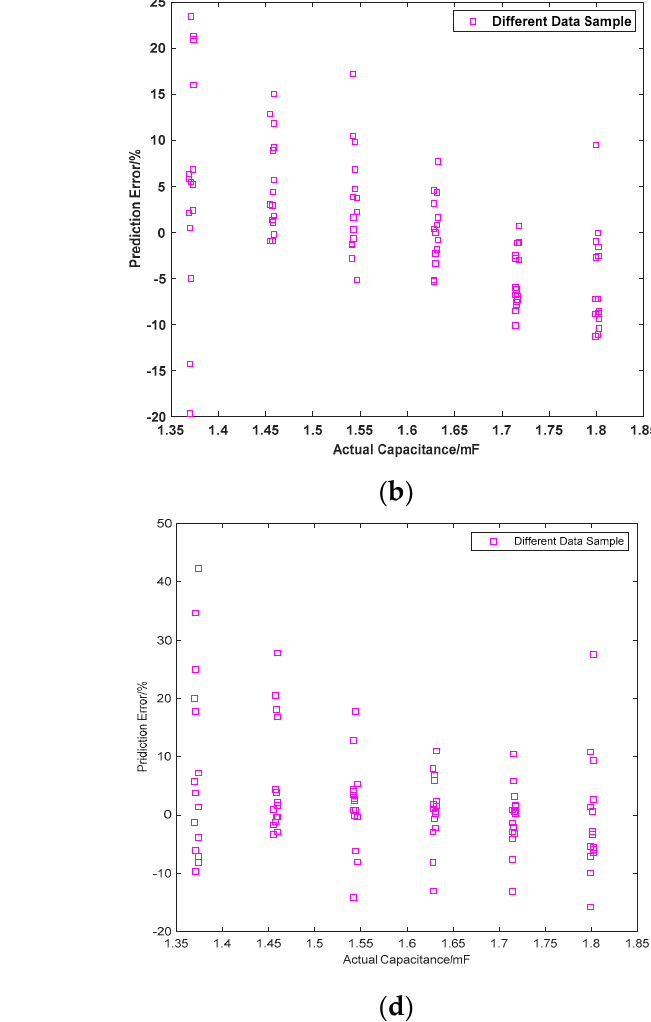
Figure 12. C estimation results under experiments by ANN ( a ) a best fitting showing train, test and validation results when Nc = 10; ( b ) cross validation showing PEs for 10 fittings under 10 random data divisions when Nc = 10; ( c ) a best fitting showing train, test and validation results when Nc = 100; ( d ) cross validation showing PEs for 10 fittings under 10 random data divisions when Nc = 100. The ESR estimation from 10 random trainings would have a much lower PE of ap- proximately ± 2%, while that for C estimation at Nc = 10 is as high as ± 25%. Even when Nc is increased to 100, the MAPE is still 6.91% as shown in Table 2. The MAPE for ESR is 0.96% while that for C is 6.18% at 10 neurons. As shown in Figure 12c, a typical over-fitting is found on the C estimation when Nc = 100. The training data are well fitted, but the test and validation data are poorly fitted. As a result, the MAPE is very high, and the PE can reach over 40% as shown in Figure